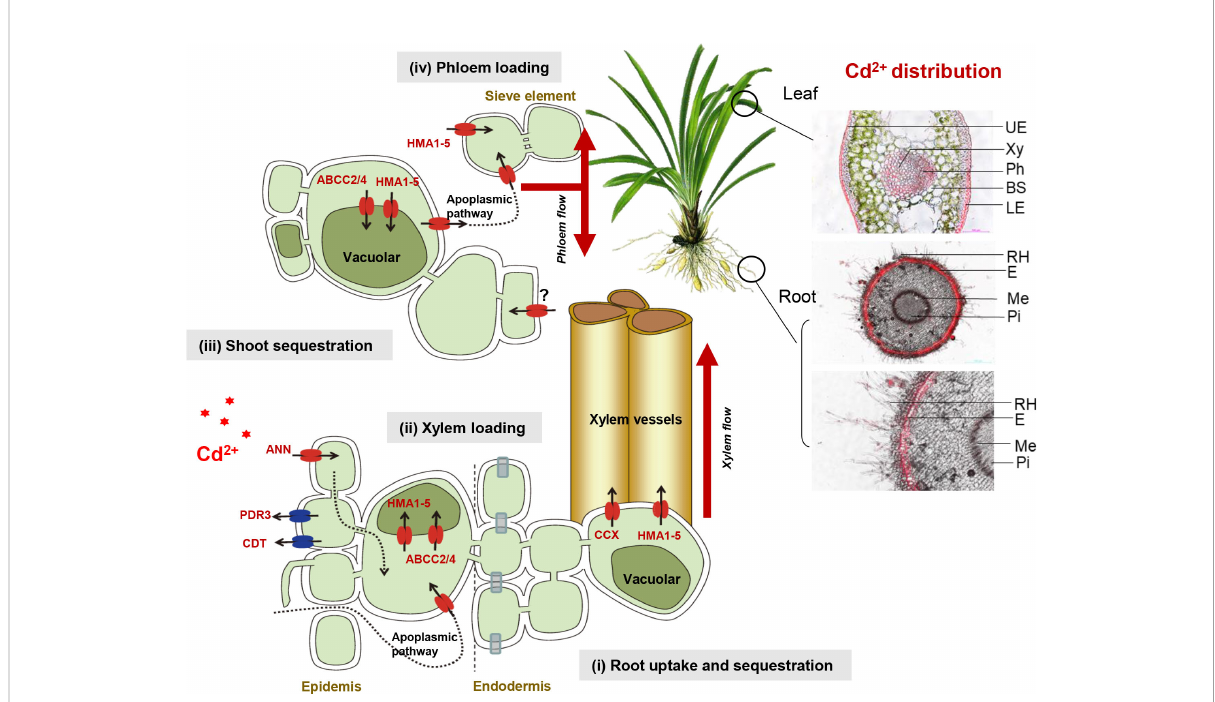
FIGURE 6 A schematic model of Cd uptake and accumulation in Zhe-Maidong. Cd 2+ from the soil can diffuse or be carried passively by water fl ow in the apoplast of the root cortex (apoplastic pathway). ANN plays a vital role in Cd uptake in Zhe-Maidong. HMA1-5 could bind Cd and induce Cd 2+ in fl ux from the cytoplasm to the vacuole. In addition, HMA transporters also play an essential role in loading Cd in xylem vessels and phloem loading. MRP transporters (ABCC) were responsible for the in fl ux of PC-Cd complexes into the vacuole. The PDR8 and CDT1 may be crucial in Cd ef fl ux, in contrast to CAX, HMA, and